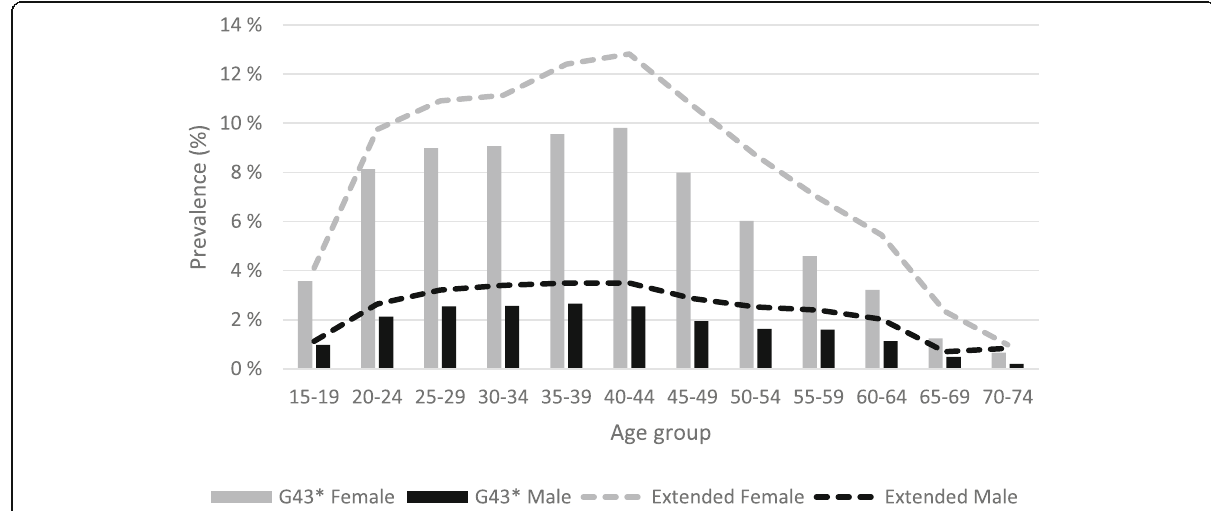
Fig. 2 Prevalence of migraine by age group and gender in the occupational health care register. Migraine was defined as a person having G43*at least once (primary cohort, bars), or one of the following: G43*, triptan prescription, any prescription with migraine in the text field (=ext., extended cohort, lines). Female patients (grey), male patients